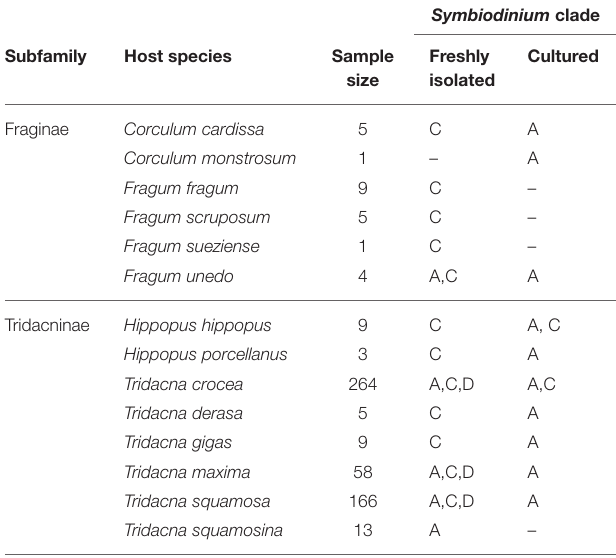
Letters indicate the Symbiodinium clade type. See Supplementary Table 2 for detailed information on each study, including geographical distribution, study methods, genetic markers used, and